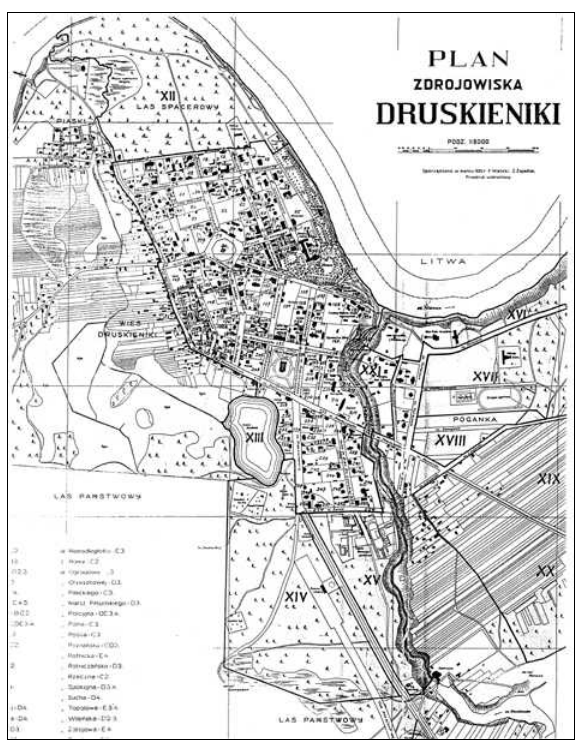
Fig. 2. Plan of Druskininkai, 1935 venamasis namas su vaistine, buitinio